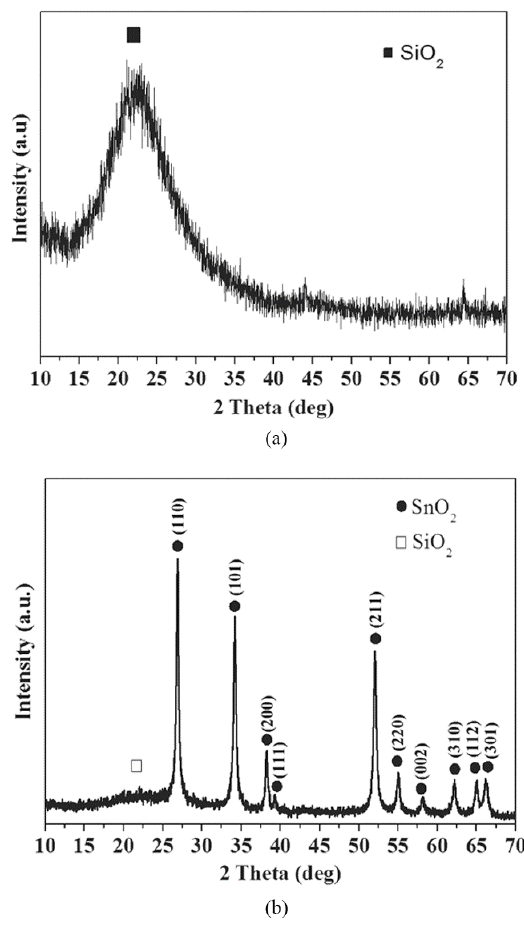
Figure 1. XRD obtained for (a) biogenic SiO (b)